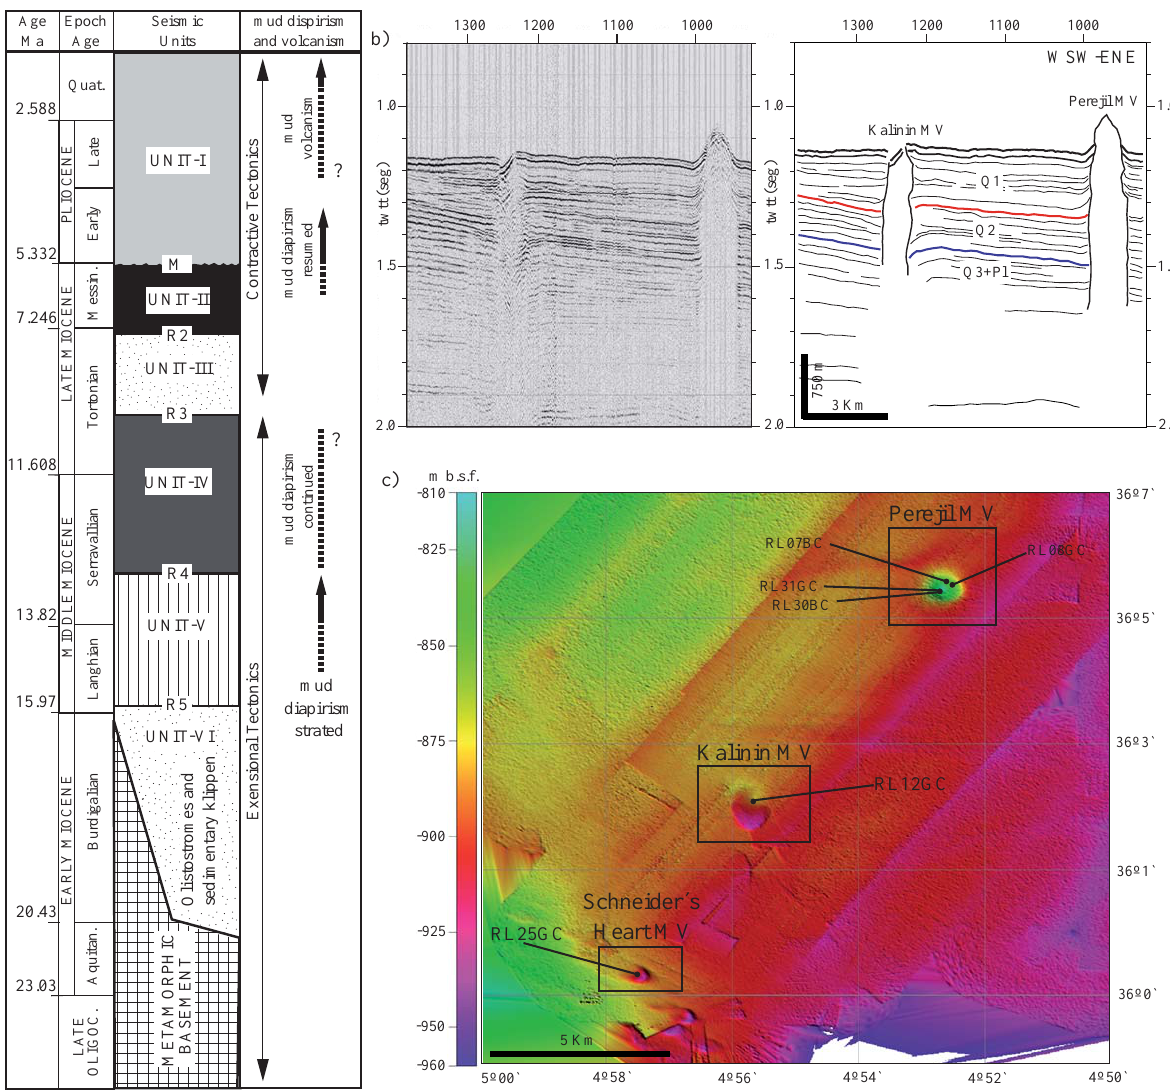
Figure 2. (a) Seismic stratigraphic units, major regional reflectors and main sedimentary sequence documented in the Betic Neogene basins (modified after Jurado and Comas, 1992; Rodríguez-Fernández et al., 1999); M: Messinian unconformity. R: reflectors correspond to major unconformities within sediments. (b) High-resolution seismic line PS200MS across Perejil and Kalinin MVs (Talukder, 2003); Blue and red lines refer to seismic reflectors within the Plio-Quaternary sequence (Unit I) (Jurado and Comas, 1992; Comas et al., 1999). (c) Multibeam swath bathymetry of the Northern MV field showing Perejil, Kalinin and Schneider’s Heart MVs. Numbers referred to studied sites (gravity and